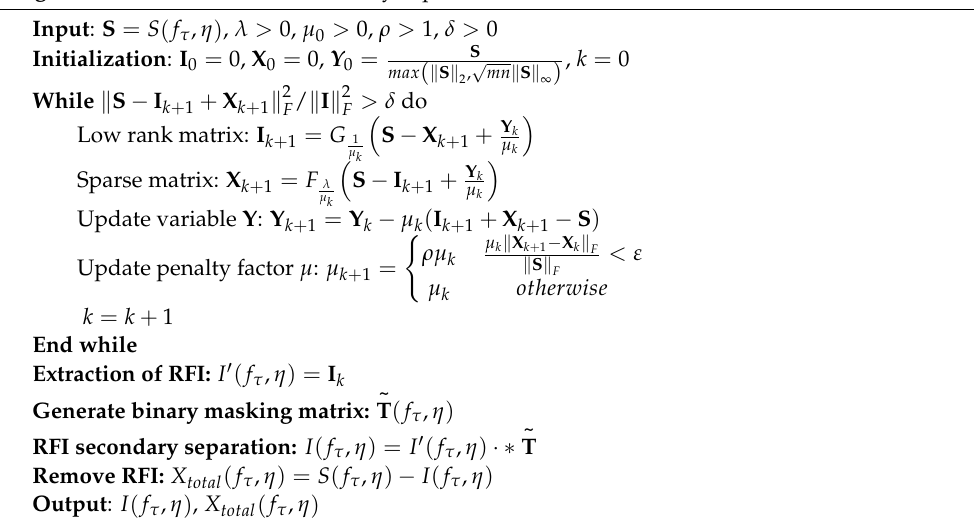
Algorithm 1 Extraction and Secondary Separation of